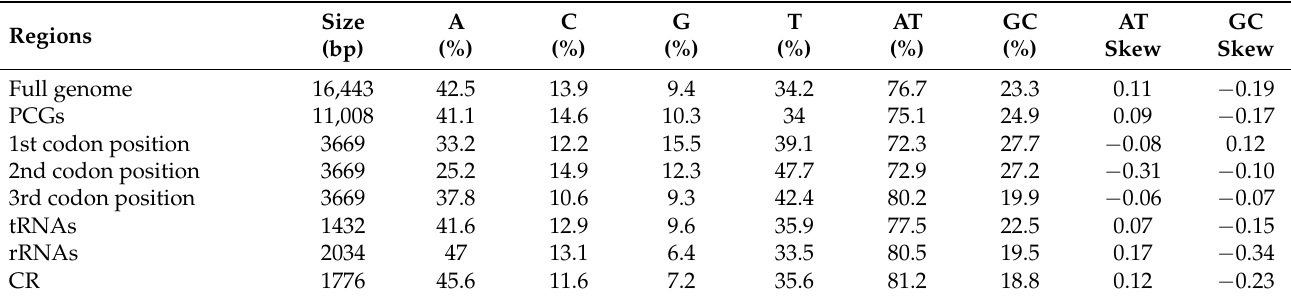
Table 2. Nucleotide composition and skewness of mitogenomes of C. sanguineus klapperichi